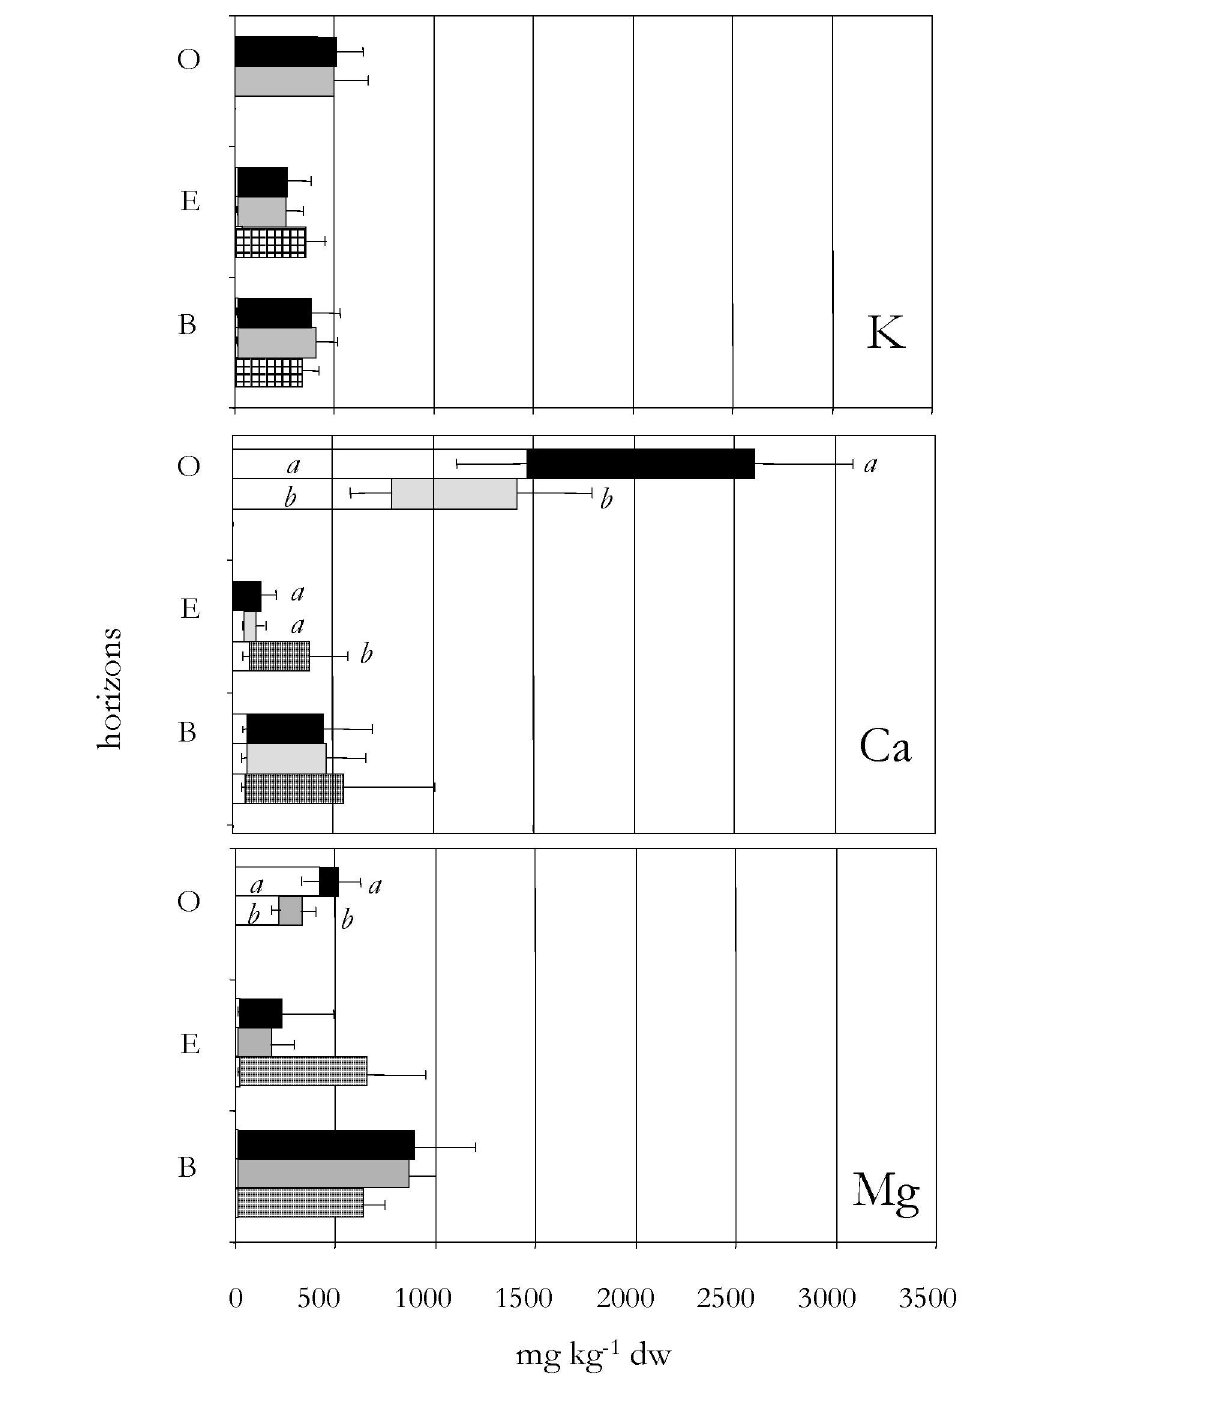
Fig. 2a. Total concentration of K, Ca and Mg in different soil horizons beneath different fruticose lichen cover: B ample, I TJ reduced , E poor. I TJ indicates plant available concentrations of the cations. Significant dif ferences (P<0.05) between plots with different lichen cover are indicated by